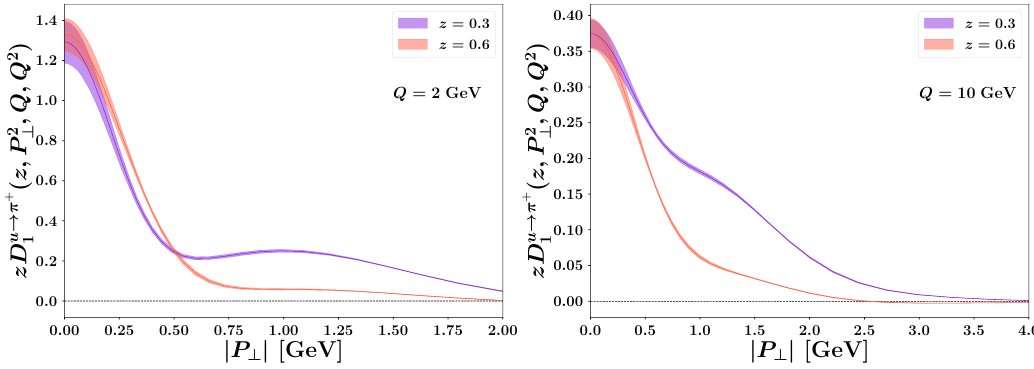
Figure 14 . The TMD FF for an up quark fragmenting into a π + at µ = √ ζ = Q = 2 GeV (left panel) and 10 GeV (right panel) as a function of the hadron transverse momentum and 0.6. The uncertainty bands represent the 68 %